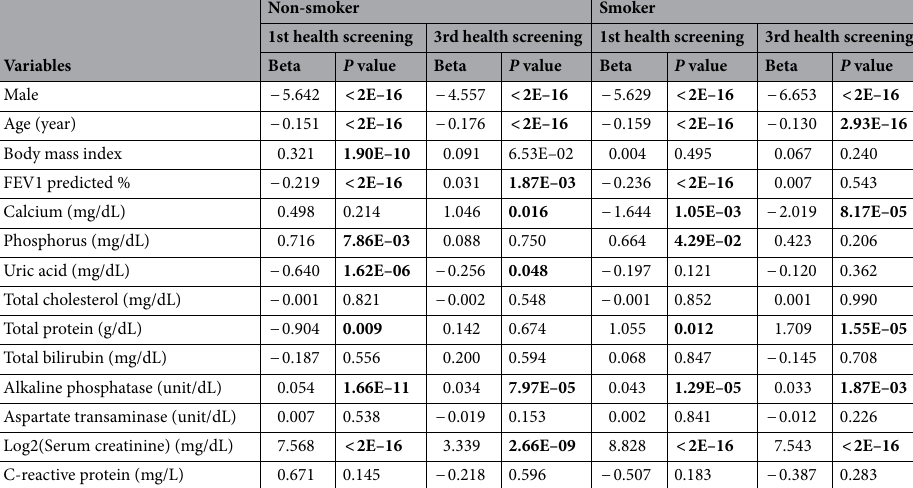
Table 4. Associations between clinical and serum parameters and FEV1 decline rate at the first and third health screenings by smoking status. Bolds represent significant results ( P < 0.05).